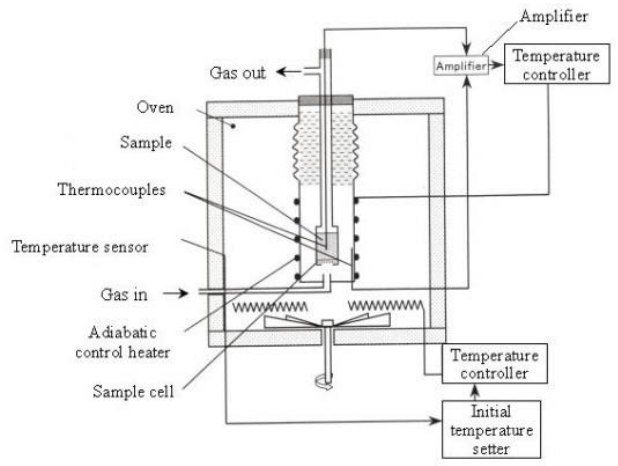
Figure 3. Schematic diagram of the spontaneous-ignition tester used in this study.